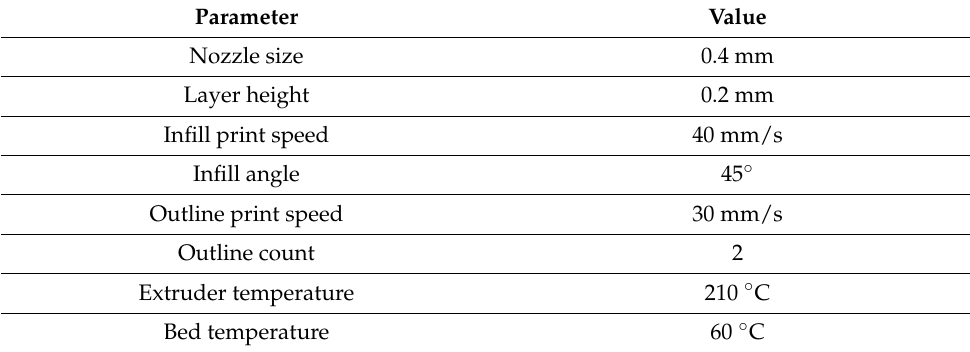
Table 3. Three-dimensional printing